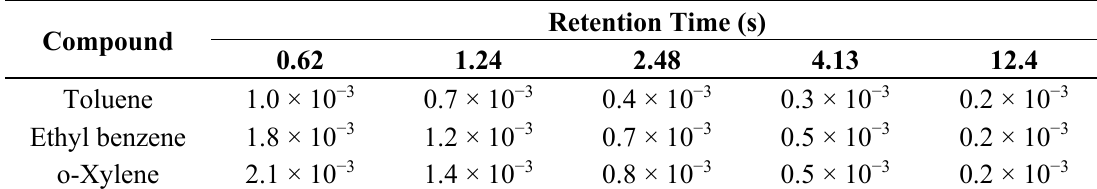
Table 2. Reaction rates (μmol·m −2 ·s −1 ) of three target compounds obtained using the N–F–TiO 2 -6 according to retention